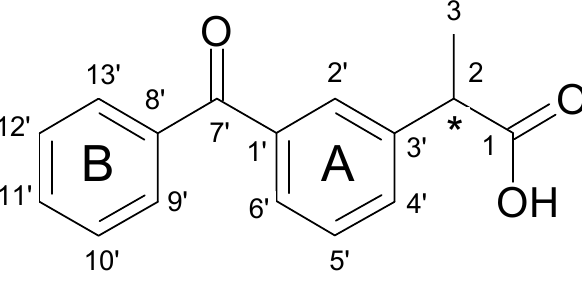
Figure 9. The structure of KP (racemic) with numbering of atoms . Table 2. The experimental 1 H and 13 C NMR chemical shifts δ (ppm) for racemic ketoprofen (KP) in D 2 O, C = 0.5 m M , pH 4.6, temperature of 25 °C.